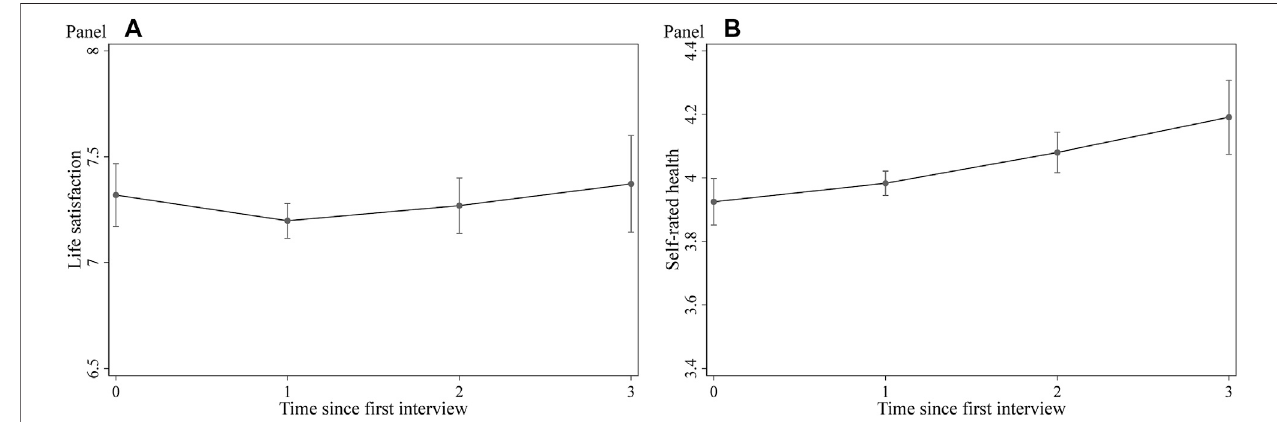
FIGURE1 | Development oflife satisfaction and self-rated health over time. Note . Conditionalpro fi le plots estimated byrandom effects growth curvemodels of life satisfaction (left-hand side) and self-rated health (right-hand side). The full regression results are displayed in Supplementary Table S7 (model S7.1) and S8 (model S8.1) of the online appendix. Dependent variables: Overall life satisfaction (0 – 10) and self-rated health (1 – 5). Control variables: dynamic postarrival mechanisms (labor market status, legal status, language pro fi ciency, and accommodation), gender, age, socioeconomic status before migration, arrival year, highest professional educational attainment, survey year fi xed effects, federal state fi xed effects, third person present at the interview, dummies indicating the number of interviews (panel conditioning), indicator for answering sensitive questions, and indicators for missing values in independent variables. Data : IAB-BAMF-SOEP Survey of Refugees, waves 1 –